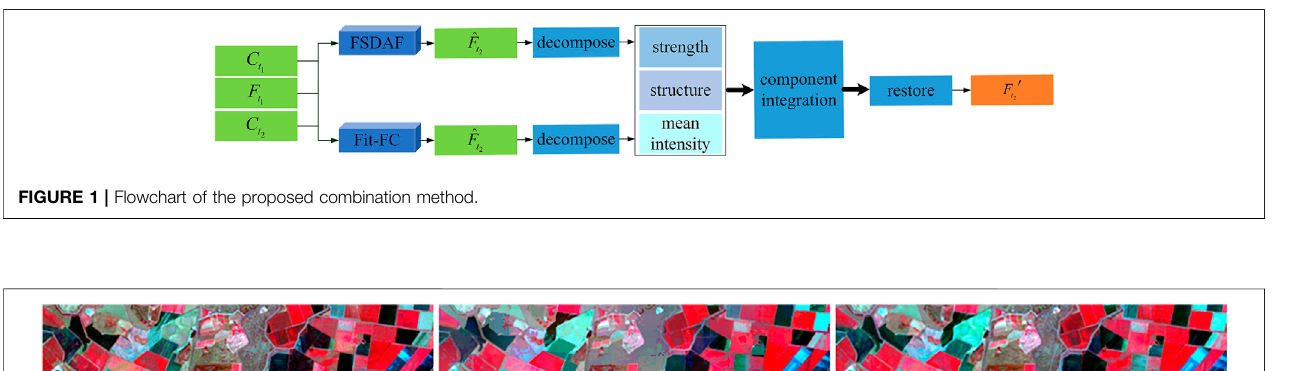
Frontiers in Environmental Science |